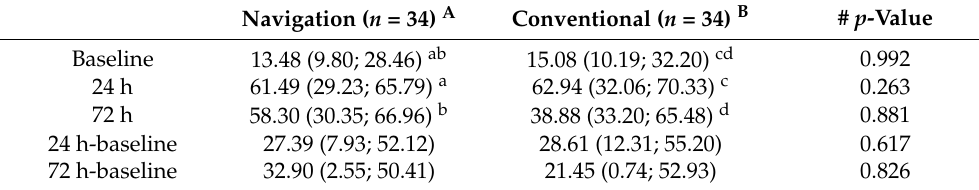
( p = 0.046) after TKA, respectively (Table 2) (unit: